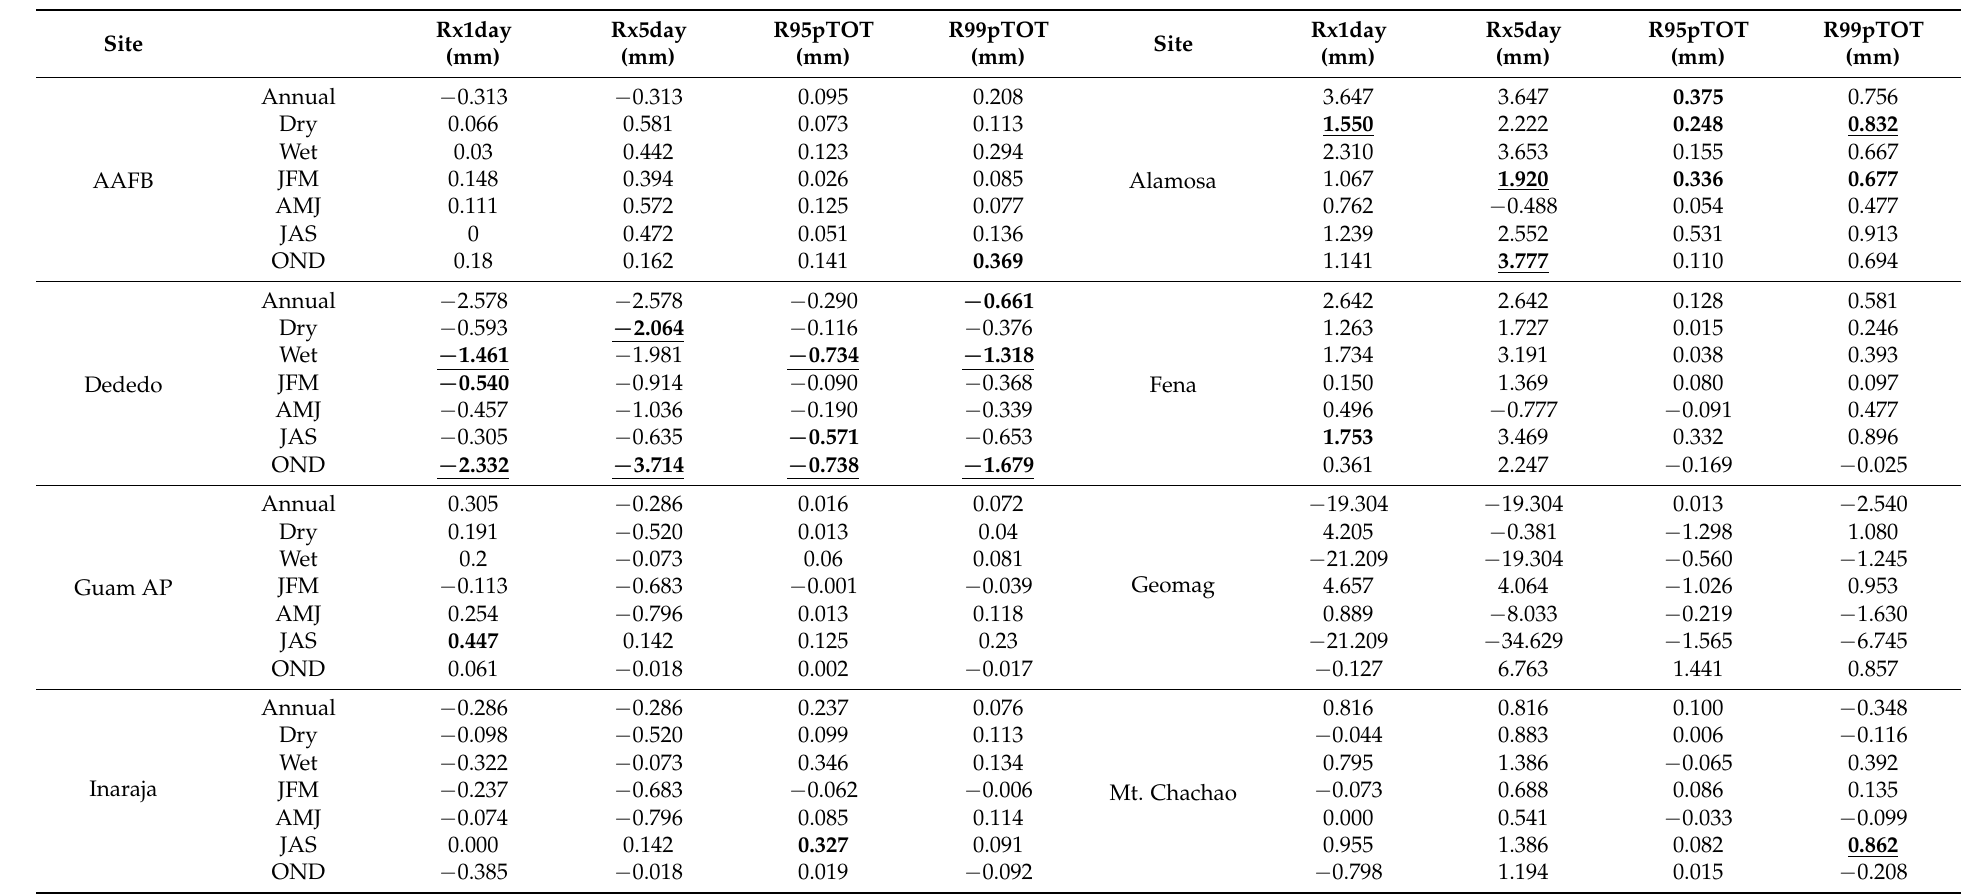
Table 6. Magnitudes (Sen’s slopes) of the increasing or decreasing trends in Rx1day, Rx5day, R95pTOT, and R99pTOT. Bold and underlined values represent a statistically significant strong trend ( p ≤ 0.05), and those bold represent a significant trend (0.05 < p -value ≤